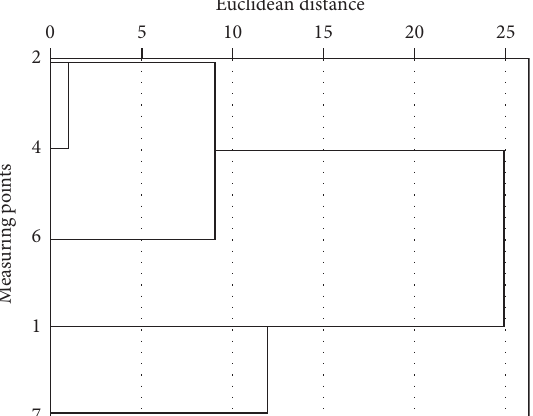
Figure 7: Cluster analysis results of temperature data from measuring